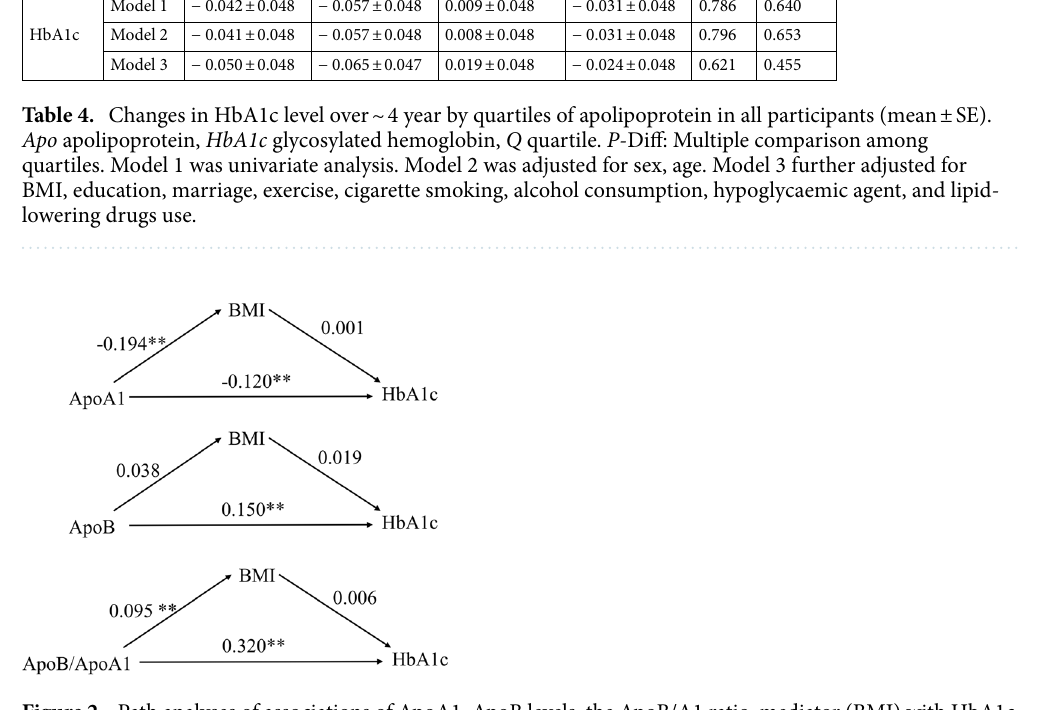
Figure 2. Path analyses of associations of ApoA1, ApoB levels, the ApoB/A1 ratio, mediator (BMI) with HbA1c in subjects. Apo Apolipoprotein, BMI body mass index, HbA1c glycated haemoglobin; ** P <